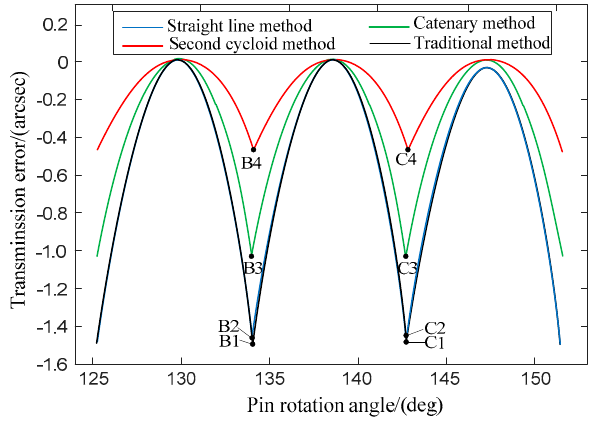
Figure 12. Transmission error curves of modified tooth profiles.